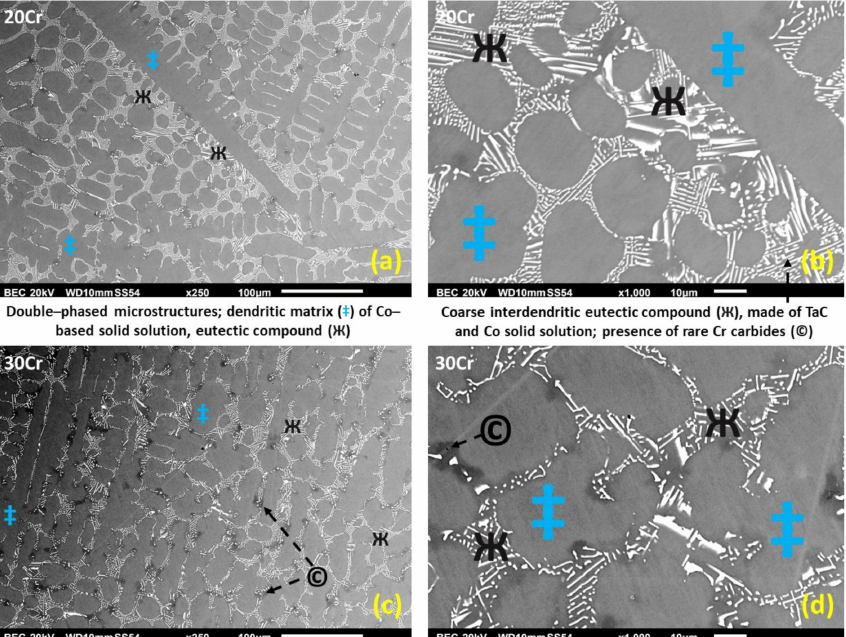
Figure 3. As-cast microstructures of the 20Cr ( a , b ) and 30Cr ( c , d ) alloys; general ( × 250, a , c ) and detailed ( × 1000, b , d ) views.